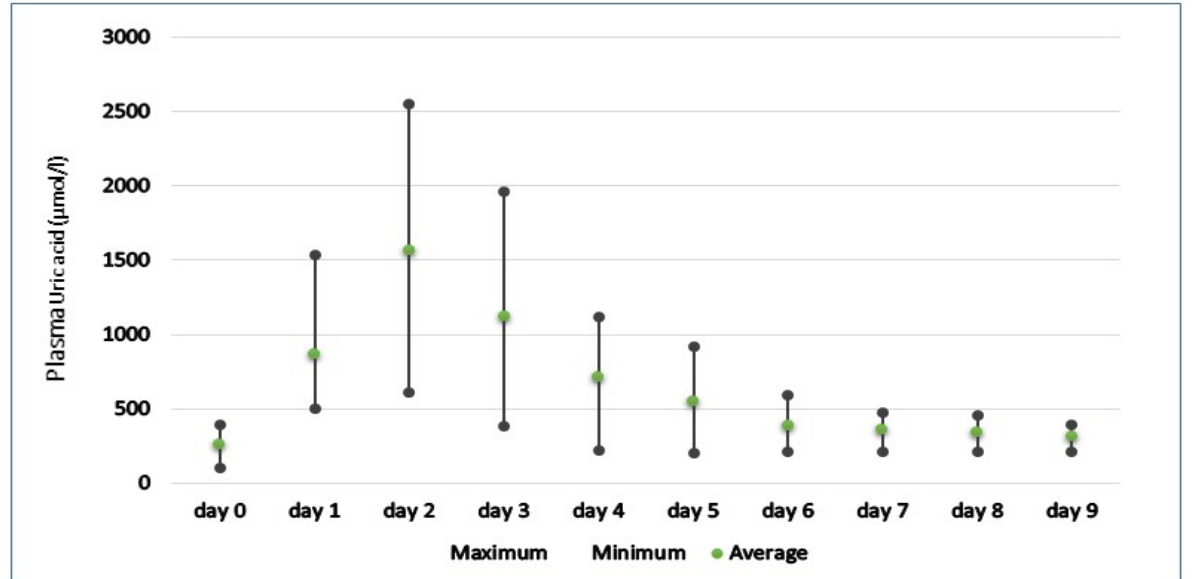
Figure 2. Pre-feeding (day 0) and post-feeding (day 1–9) plasma uric concentration range in snakes after meal 2.